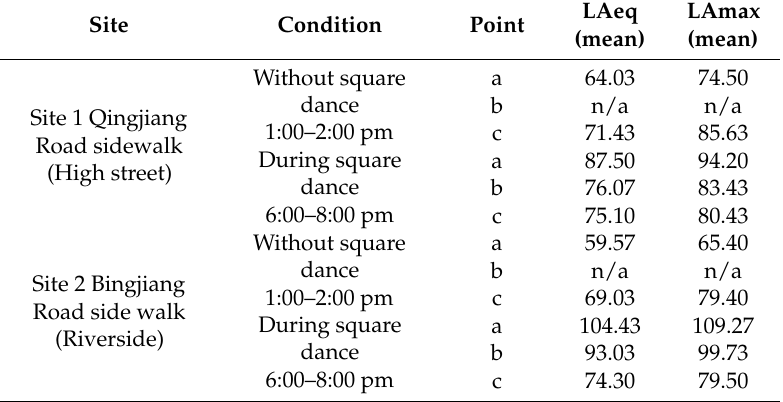
Table 2. Measurements of sound pressure levels (LAeq and LAmax) at two sites during and without square dance.